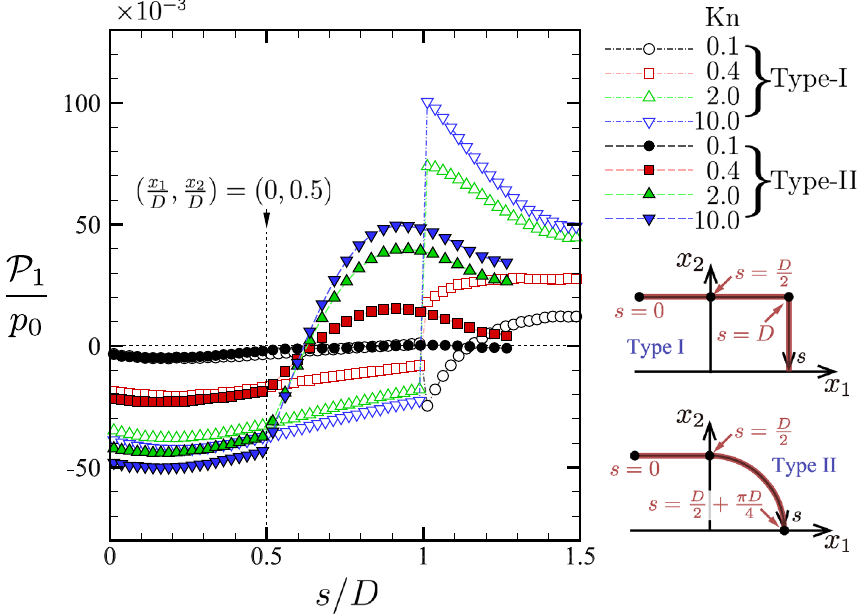
Figure 11. Profile of P 1 (Eq. (13)) along each of the U-shape bodies as a function of the length s measured ( 0.1 , 0.4, 2, and 10 in the case of T 1 / T 0 0.5, 0.5 ) for Kn from the edge ( x 1 / D , x 2 / D ) = = − − 2 . The symbols represent the numerical results, which are joined by the line segments. The empty (or H / D = filled) symbols indicate the results of type I (or type II). The inset shows the definition of the coordinate s